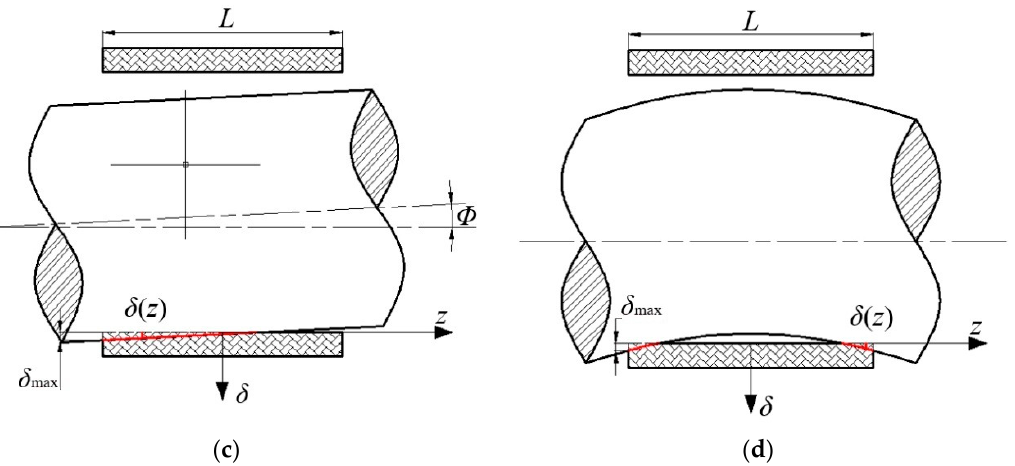
Figure 2. Contact diagram of the bearing: ( a ) the elastomeric journal bearing is installed on the steel bushing; ( b ) schematic diagram of the cross-section; ( c ) tilted shaft in contact with the bearing; ( d ) curved shaft in contact with the bearing.